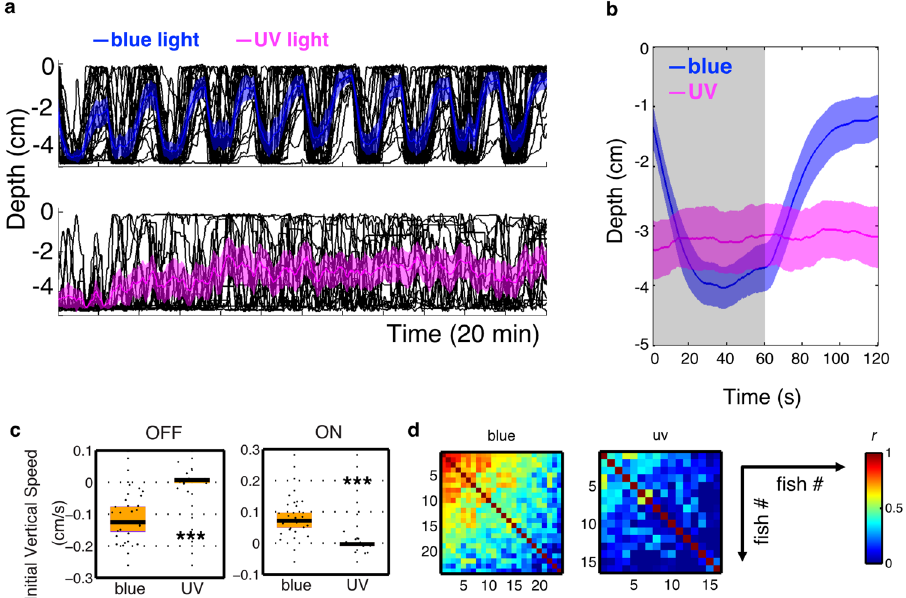
Figure 2. UV light fails to drive vertical migration. ( a ) Vertical migration of fish under blue (470 nm) and UV (375 nm) light at the same photon intensity, ~1.56 × 10 15 cm − 2 s − 1 . Black lines represent individual trajectories, and colored traces represent the average of the group. Shadows indicate 95% confidence intervals. n = 24 for the blue group and n = 16 for the UV group. ( b ) Averaged vertical migration from 10 dark-light cycles. ( c ) Initial 20 s diving and climbing speed. Vertical speeds under UV are reduced relative to the speeds under blue light (light OFF: Mann-Whitney U = 4, *** p < 0.0001, two tailed, rank-biserial correlation = 0.98; light ON: Mann- Whitney U = 6, *** p < 0.0001, two tailed, rank-biserial correlation = 0.97). Horizontal black lines indicate median values, black dots show speed of individual fish, purple blocks show the 25th and 75th percentiles and orange blocks show 95% CIs. ( d ) Correlation coefficient of vertical position across time during 10 dark-light cycles. Correlation coefficient is lower under UV light than under blue light ( U = 3442, p < 0.0001, one tailed Mann-Whitney U test; median r = 0.11 for UV and 0.45 for